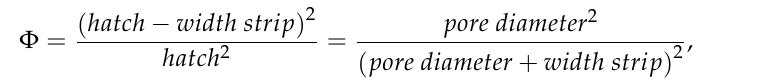
Figure 5. Correlation between hatch distance and resulting pore geometries for square pattern structure. Blue dots, width strip; red dots, pore diameter. With rising hatch distance, the pore diameters increase while the width strip remains constant.